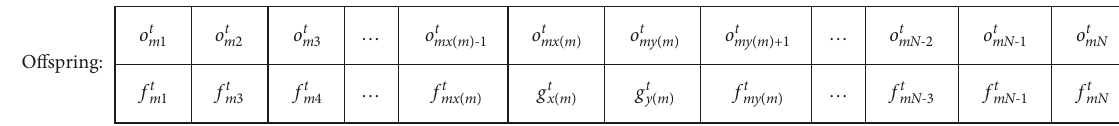
Figure 6: The offspring gene sequence in the ant colony algorithm.